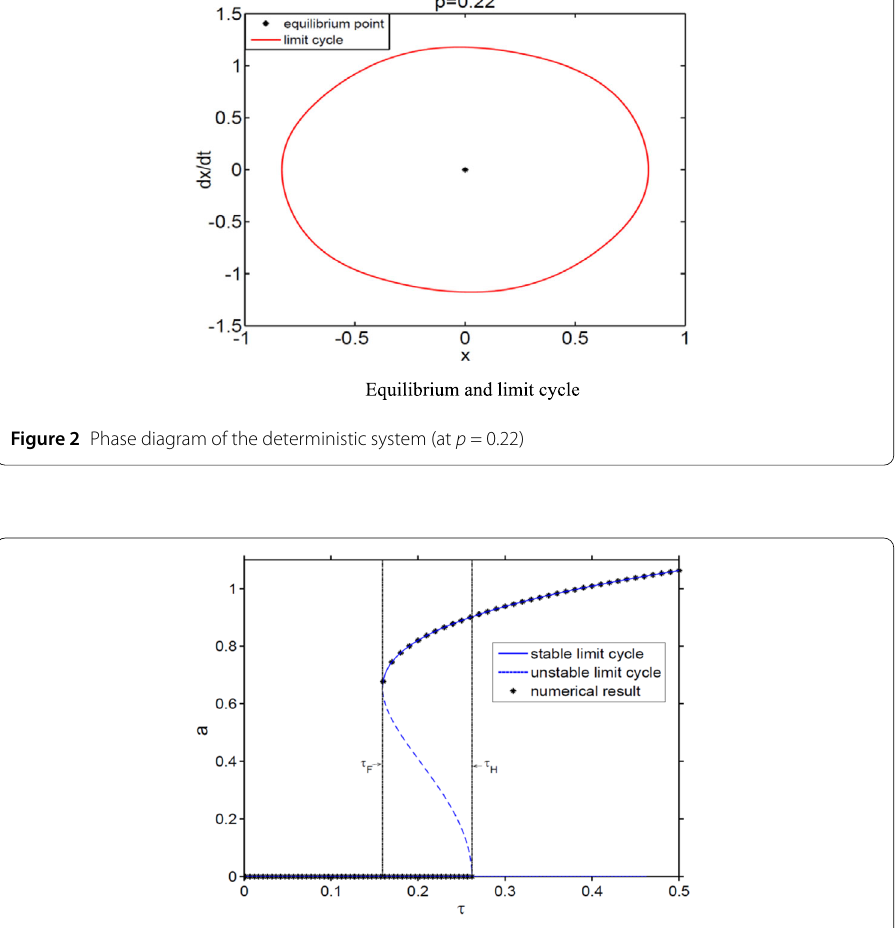
Figure 3 Bifurcation diagram of the deterministic system (with variation in τ